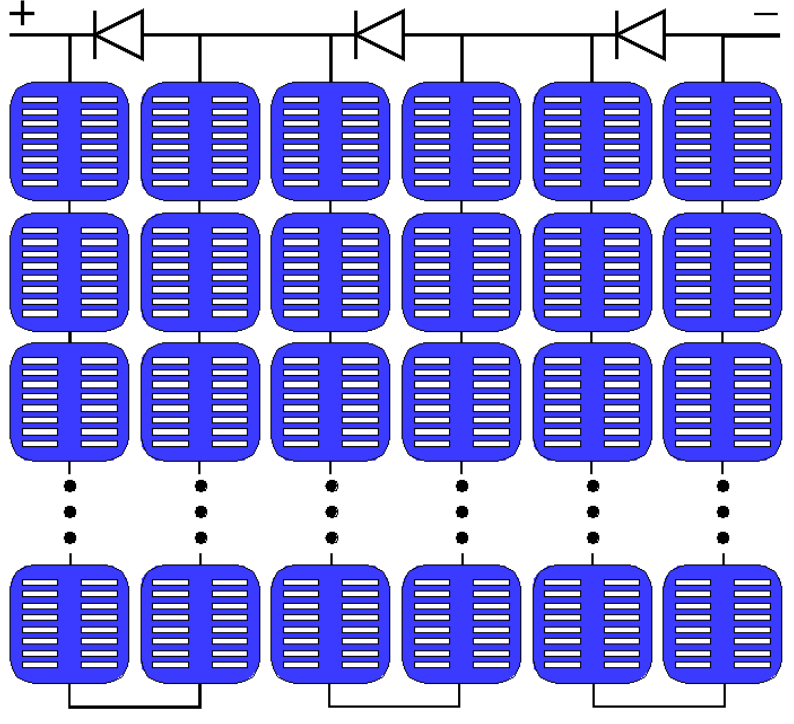
Figure 1. Arrangement of PV cells in PV module.